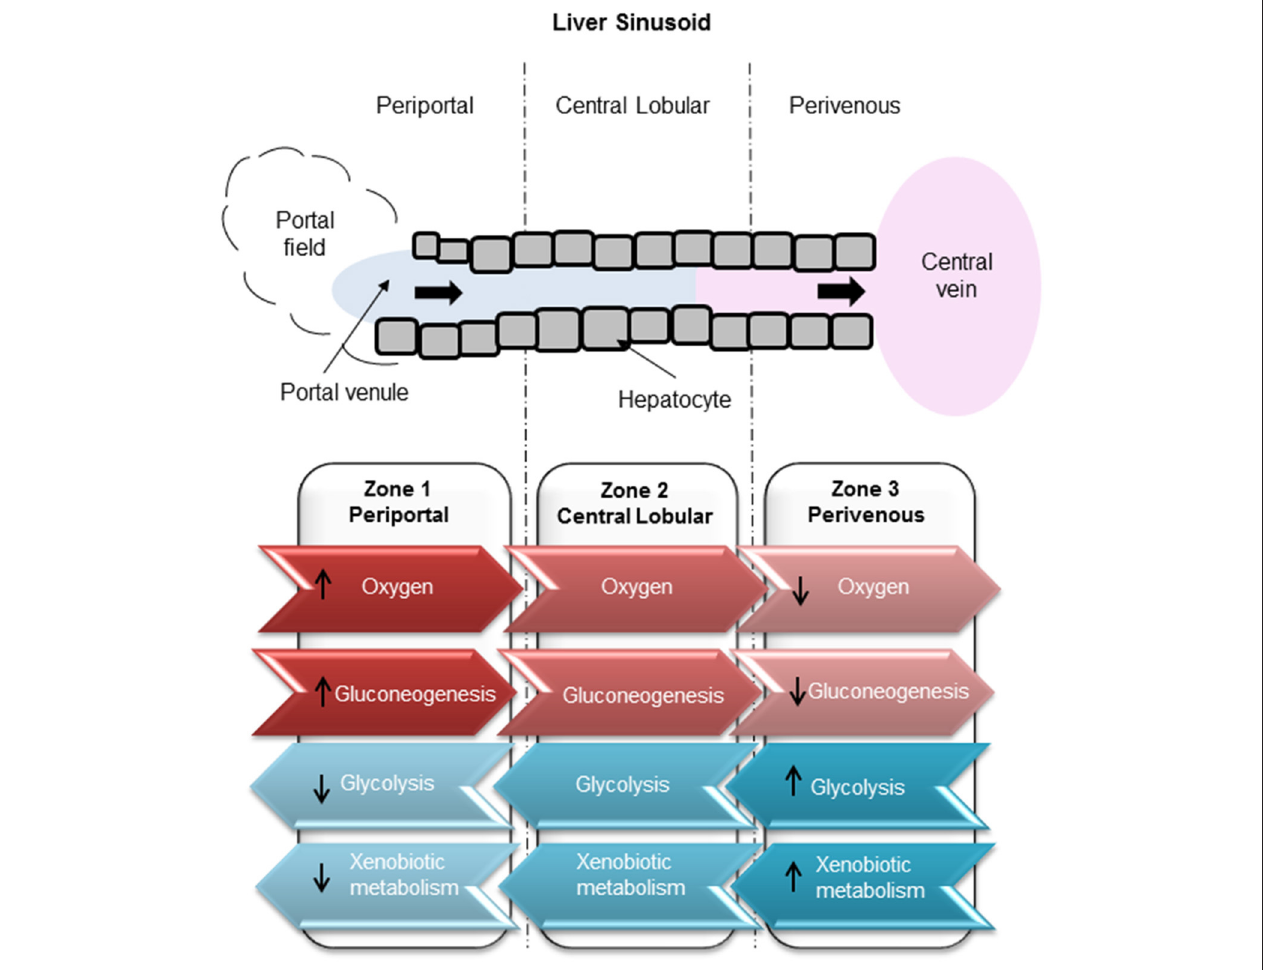
FIGURE 1 | Zonation of liver metabolism. High oxygen exposure of hepatocytes in the periportal region compared to low exposure in the perivenous zone. Glucose production carried out through gluconeogenesis in the periportal zone. Glucose utilization carried out by glycolysis in the perivenous zone.